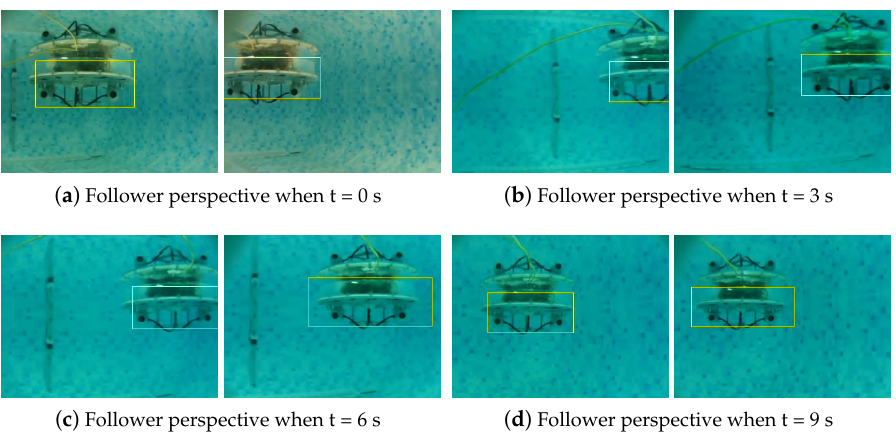
Figure 16. Images of follower perspective of two robots in a dynamic straight-line formation